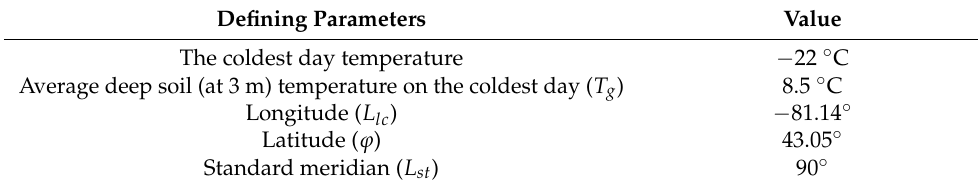
Table 2. The coordinates of London, ON, Canada, and the essential meteorological data for the coldest day there [49,50]. Defining Parameters Value The coldest day temperature Average deep soil (at 3 m) temperature on the coldest day ( T g